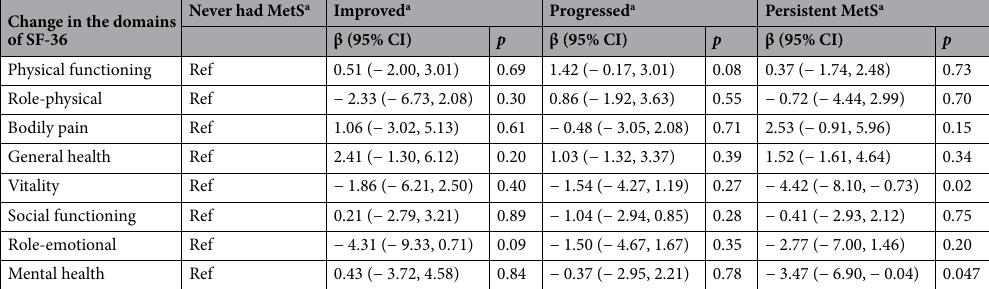
Table 4. The association between change in metabolic syndrome and change in SF-36 domains (n = 427). Multivariable linear regression models were adjusted for age, sex, marital status, level of education, smoking, alcohol consumption, baseline body mass index, and change in physical activity. SF-36 the Short Form Health Survey, MetS metabolic syndrome. a There were 298 (69.8%) participants who never had MetS. 22 (5.2%) participants had an improved MetS status. 66 (15.5%) individuals were categorized as progressed MetS group. 41 (9.6%) subjects had persistent MetS.